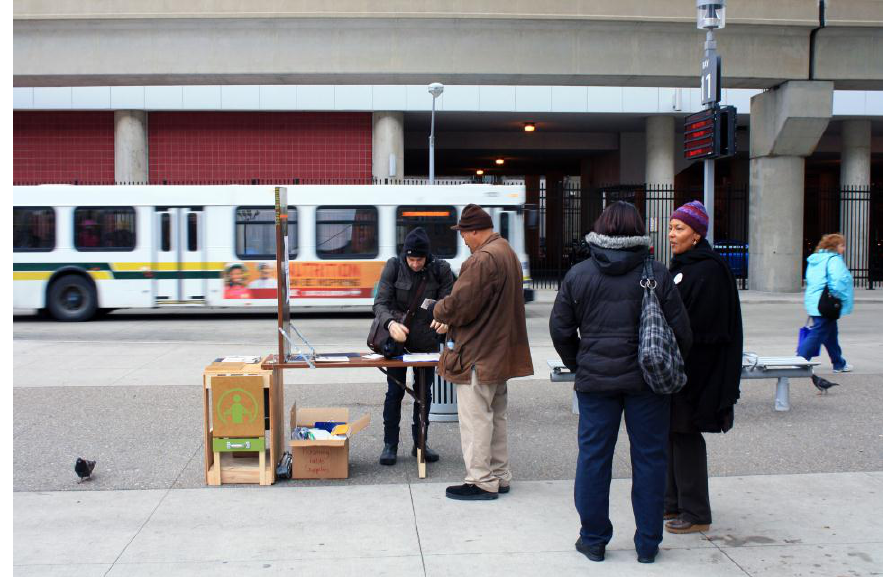
Figure 5. The project’s collapsible “roaming table” allowed the outreach team to engage over 6000 residents at transit stops, grocery stores, and community events throughout Detroit. (Photo credit: Detroit Collaborative Design